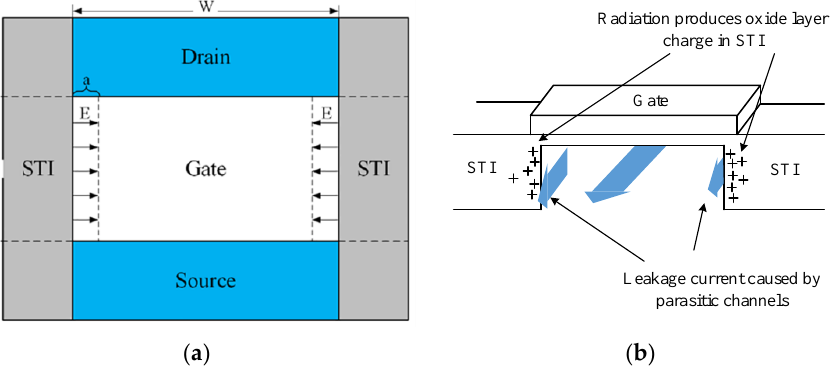
Figure 4. Drain current variations in I d – V g curves after electrical stress of ( a ) TID and ( b ) fresh devices. The W / L of the devices is 1.5 µm/0.55 µm.